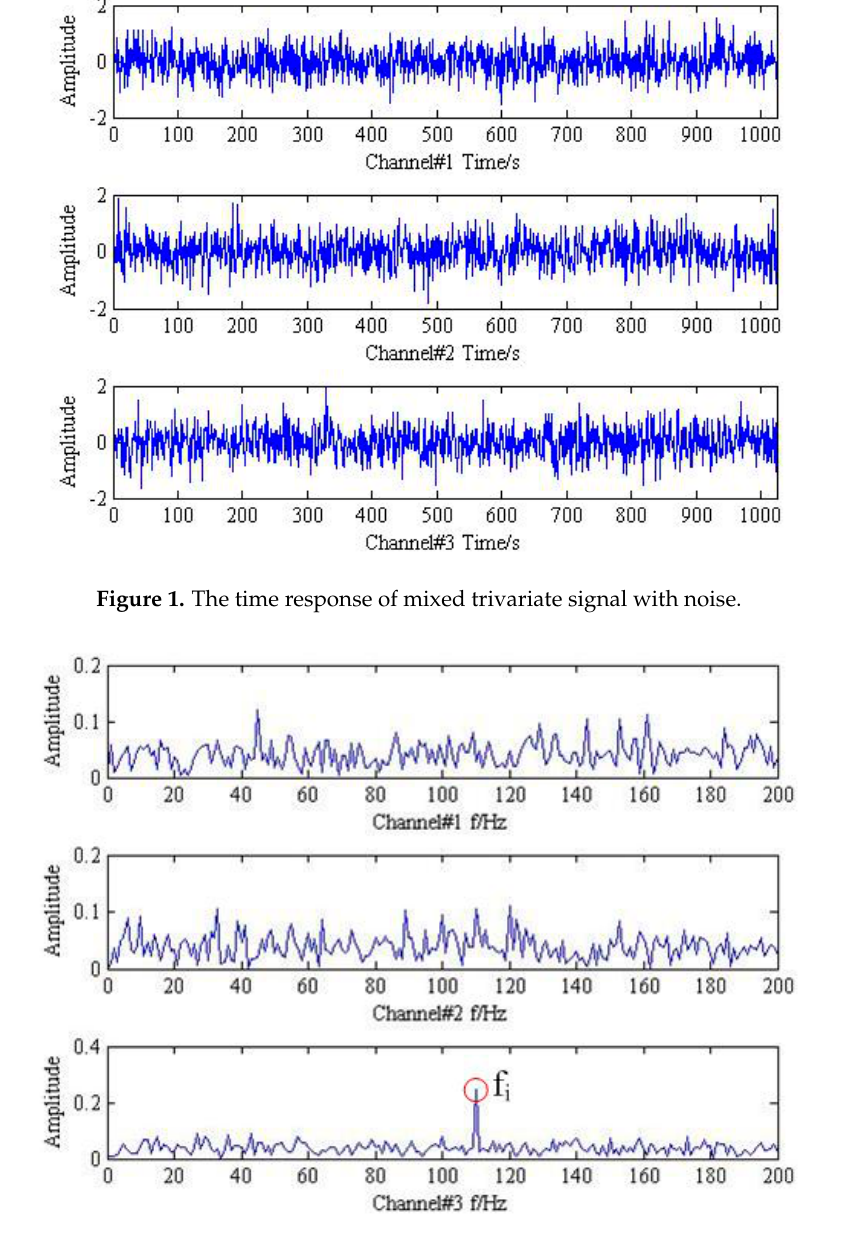
Figure 2. The frequency spectrum of mixed trivariate signal with noise.